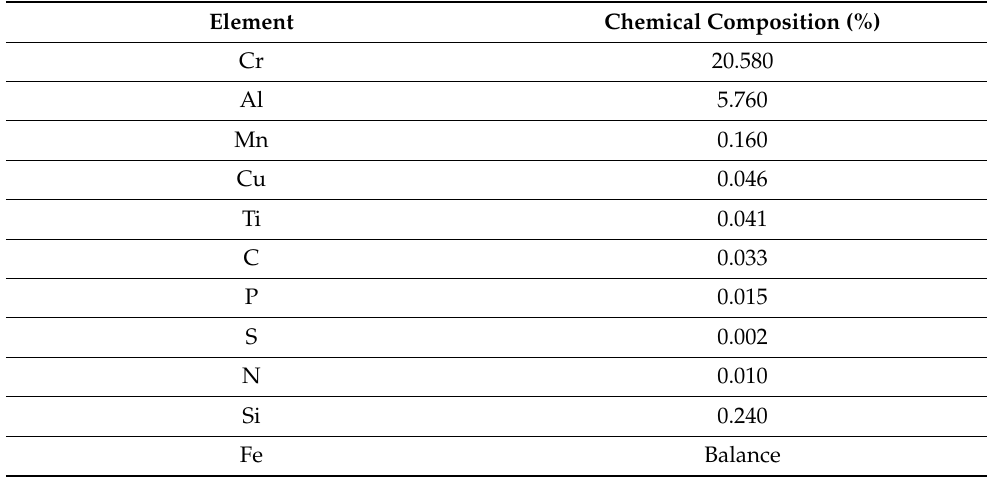
Table 1. The elemental chemical compositions of the FeCrAl sintered fibers [36].